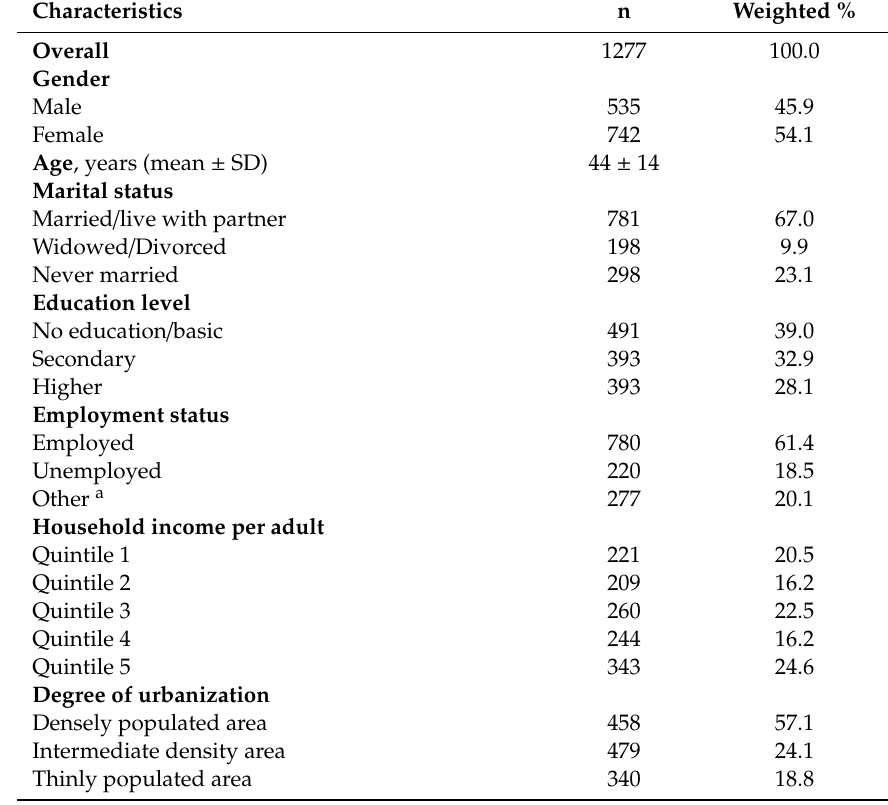
Table 1. Sociodemographic, migration-related, and access-to-care characteristics of adult immigrants ( ≥ 18 years of age) in Portugal, National Health Survey